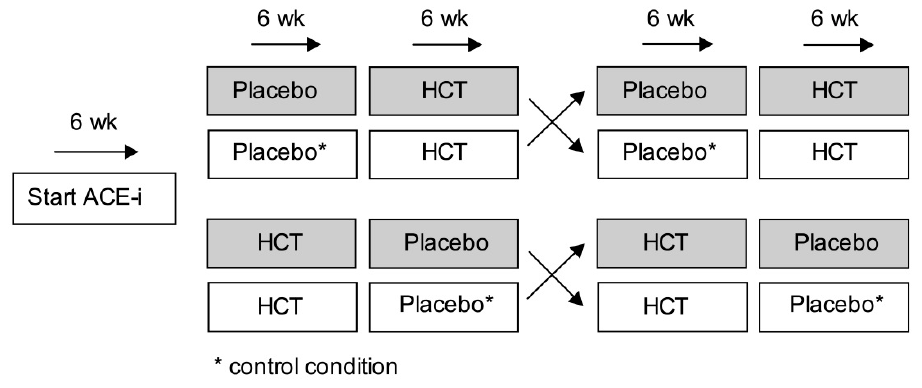
Figure 2. Schematic overview of the trial design.